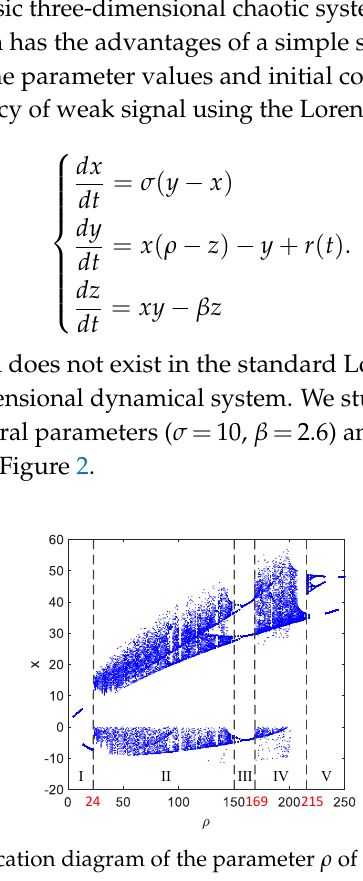
Figure 2. Bifurcation diagram of the parameter ρ of the Lorenz system.